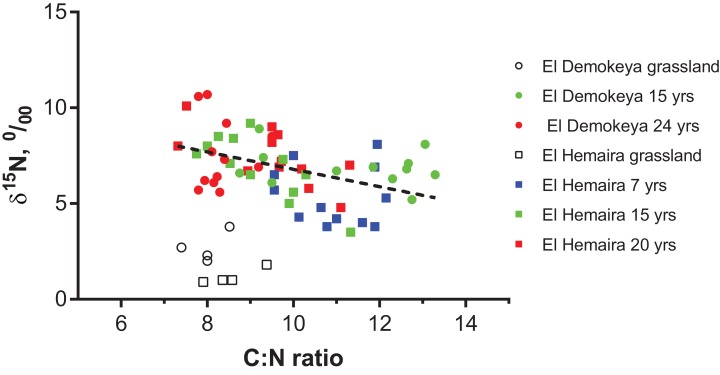
Relationship between soil δ15N (‰) and soil C:N ratios for grasslands and plantations by age for the two study sites across all plots and layers.Dashed line is the linear regression fitted to the plantation data only (Y = −0.452*X + 11.31, R2 = 0.1926, p = 0.0005).